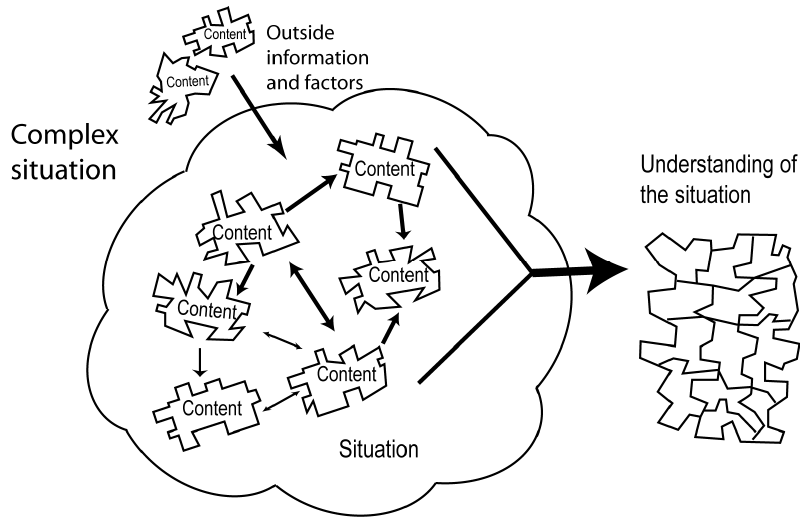
Figure 6. Relationships and the complexities of assembling information into a coherent understanding. The understanding comes from both the content and knowing how it fits